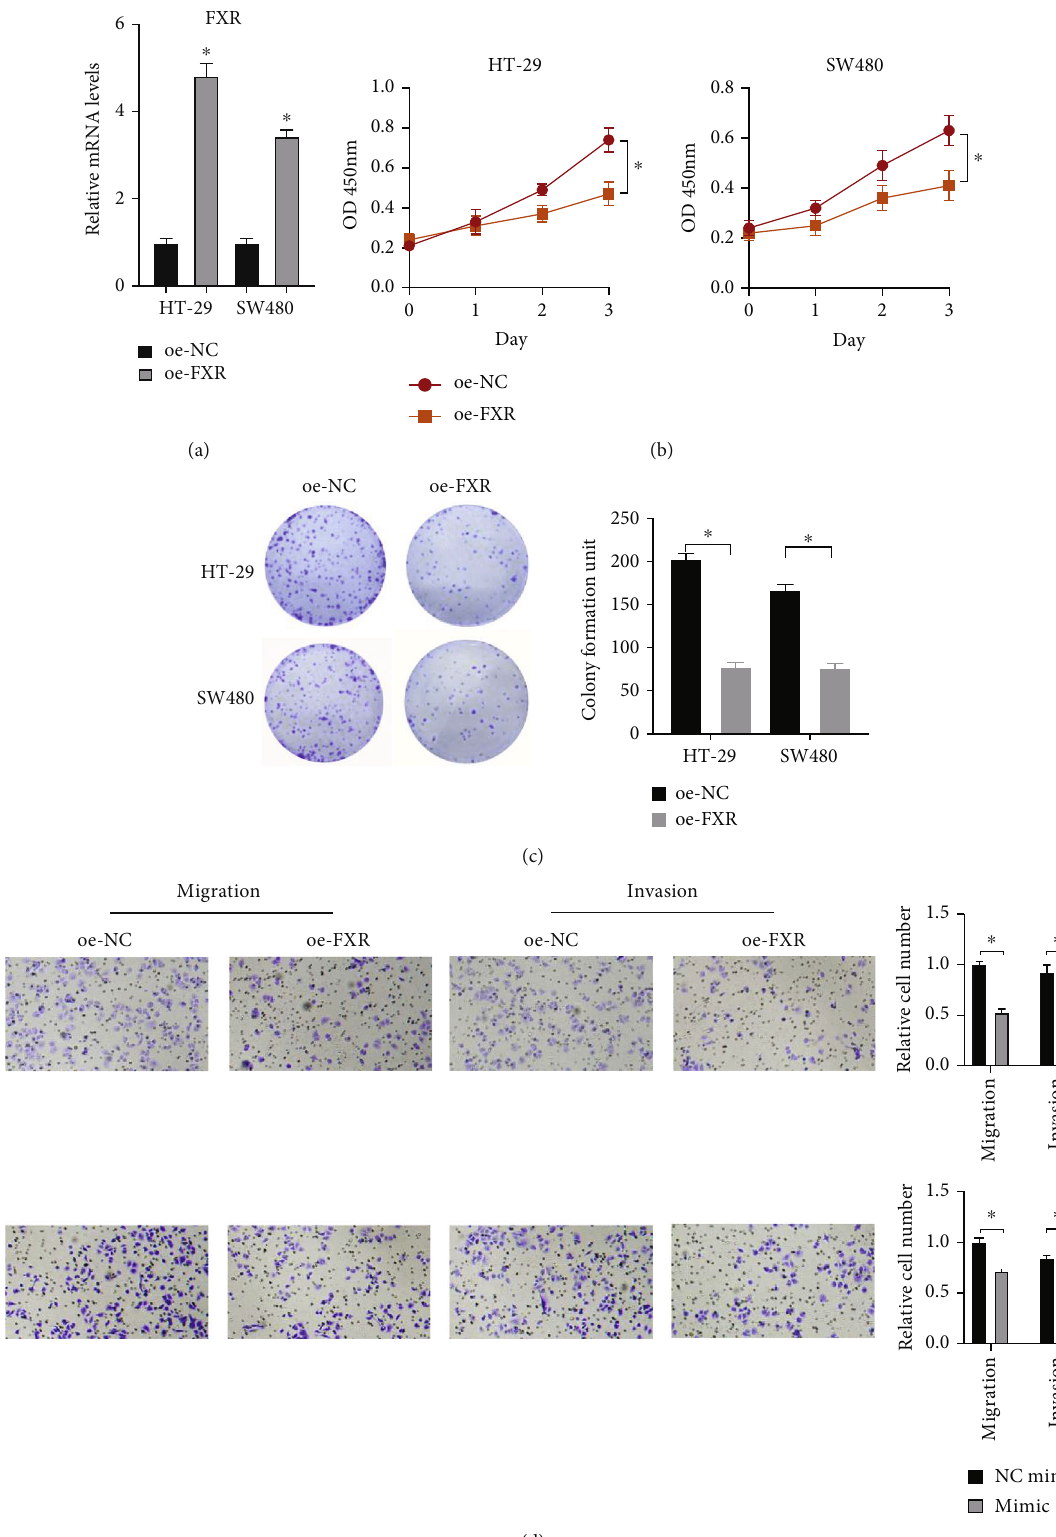
Figure 2: FXR overexpression inhibits malignant progression of colon cancer cells. (a) qRT-PCR con fi rmed the high expression of FXR in oe-FXR transfection group. (b and c) CCK-8 and colony formation assays were employed to analyze the e ff ects of FXR overexpression on proliferation of HT-29 and SW480 cell lines. (d) The Transwell migration and invasion assays assessed the changes in motor capacity of colon cancer cells after overexpressing FXR. Each column is the average value of 3 independent experiments. ( ∗ denotes P < 0 : 05